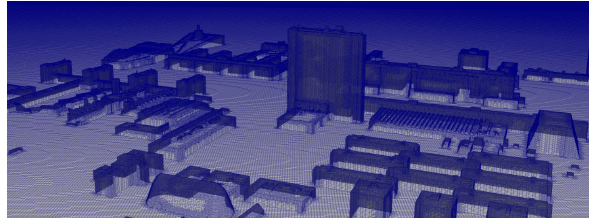
Figure 3. LoD2.2 mesh snapshot.